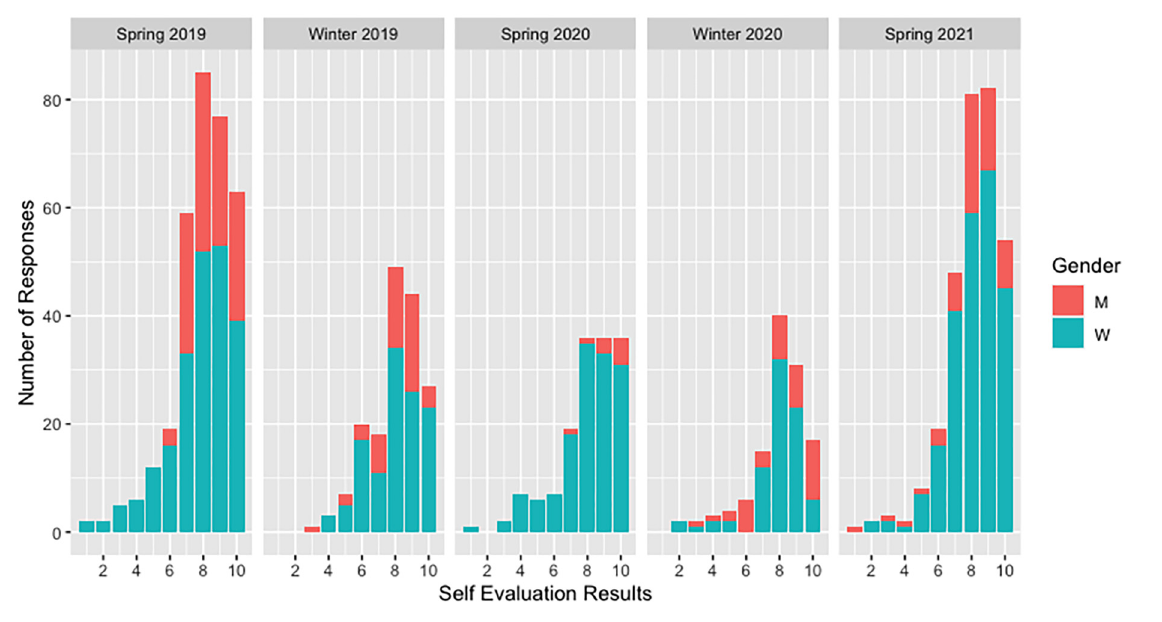
FIGURE4 Self-evaluation results distribution by semester and gender (M, Men; W, Women). The self-assessment used 10 as the highest grade and 1 as the